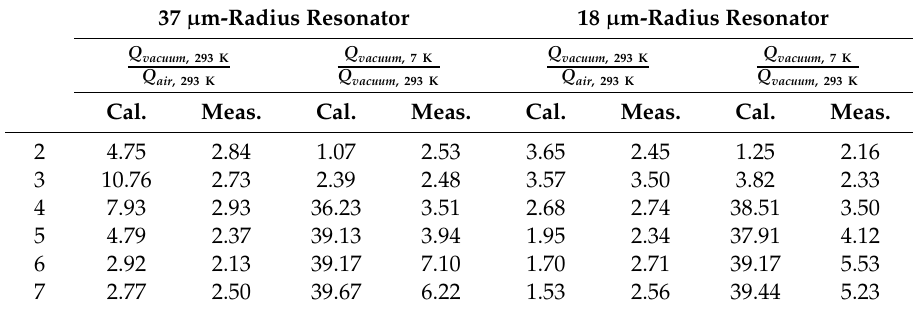
Table 3. Calculated and measured Q enhancements for the 37 and 18 µ m-radius resonators. 37 µ m-Radius Resonator 18 µ m-Radius